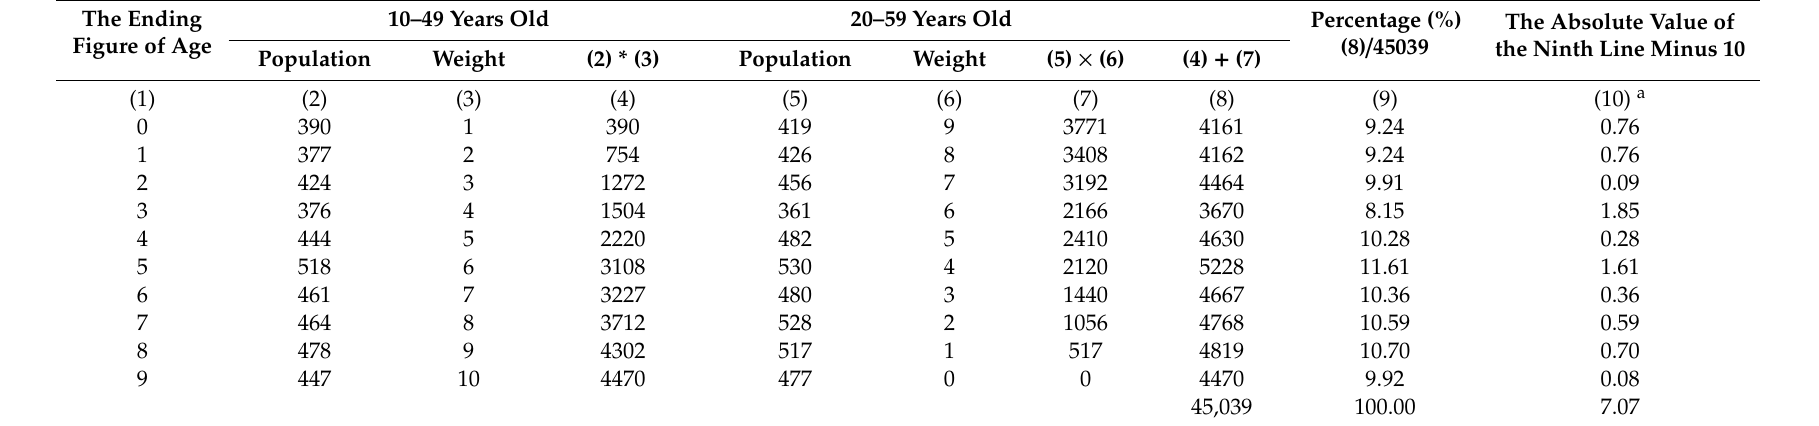
Table 1. Myers blended index evaluation schedule of three counties in Jiangxi province in